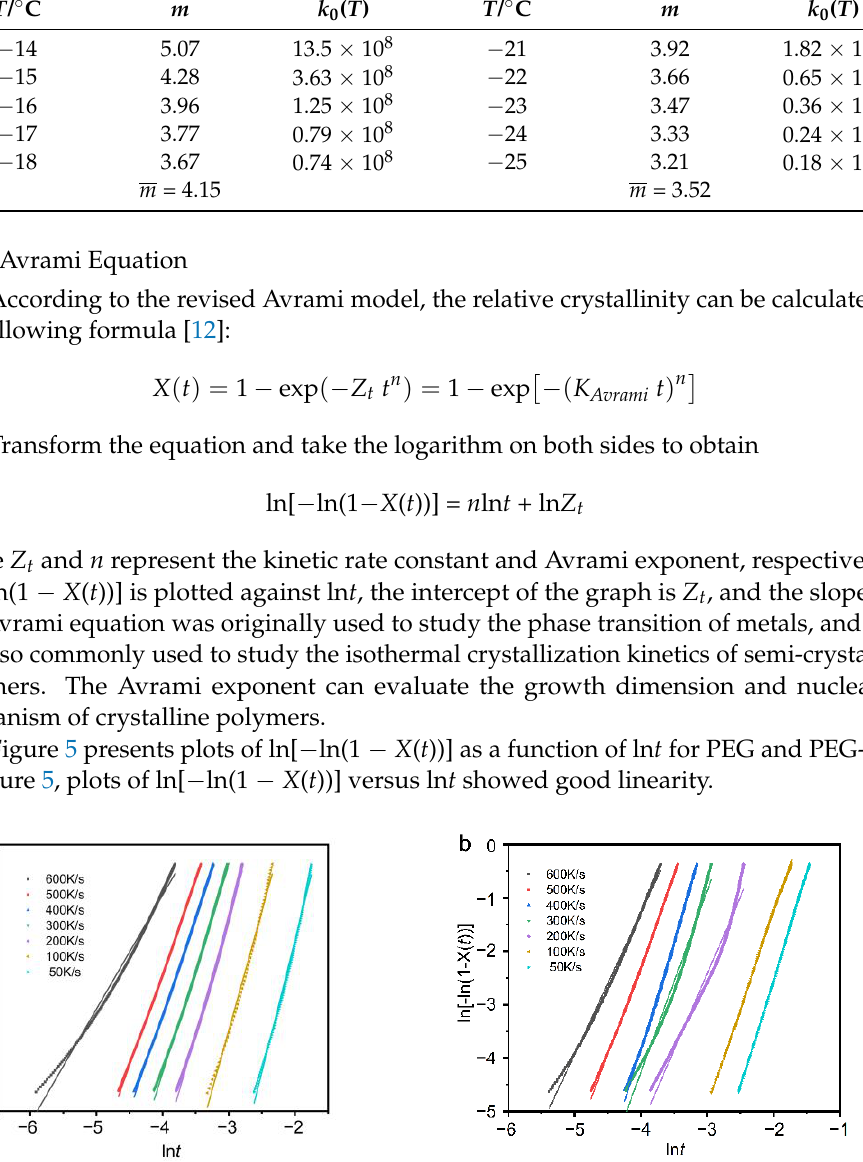
Figure 5. ( a ) PEG and ( b ) PEG-PCL non-isothermal crystallization ln[ − ln(1 − X ( t ))] plotting ln t.